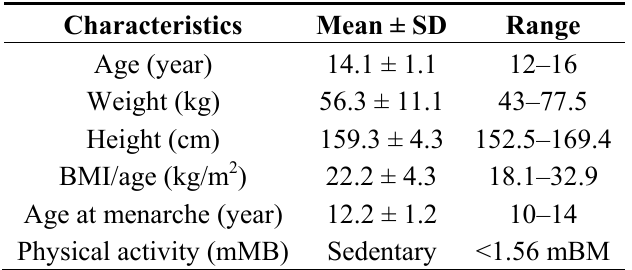
Table 2. Basal characteristics of the 24 adolescent girls participating in the